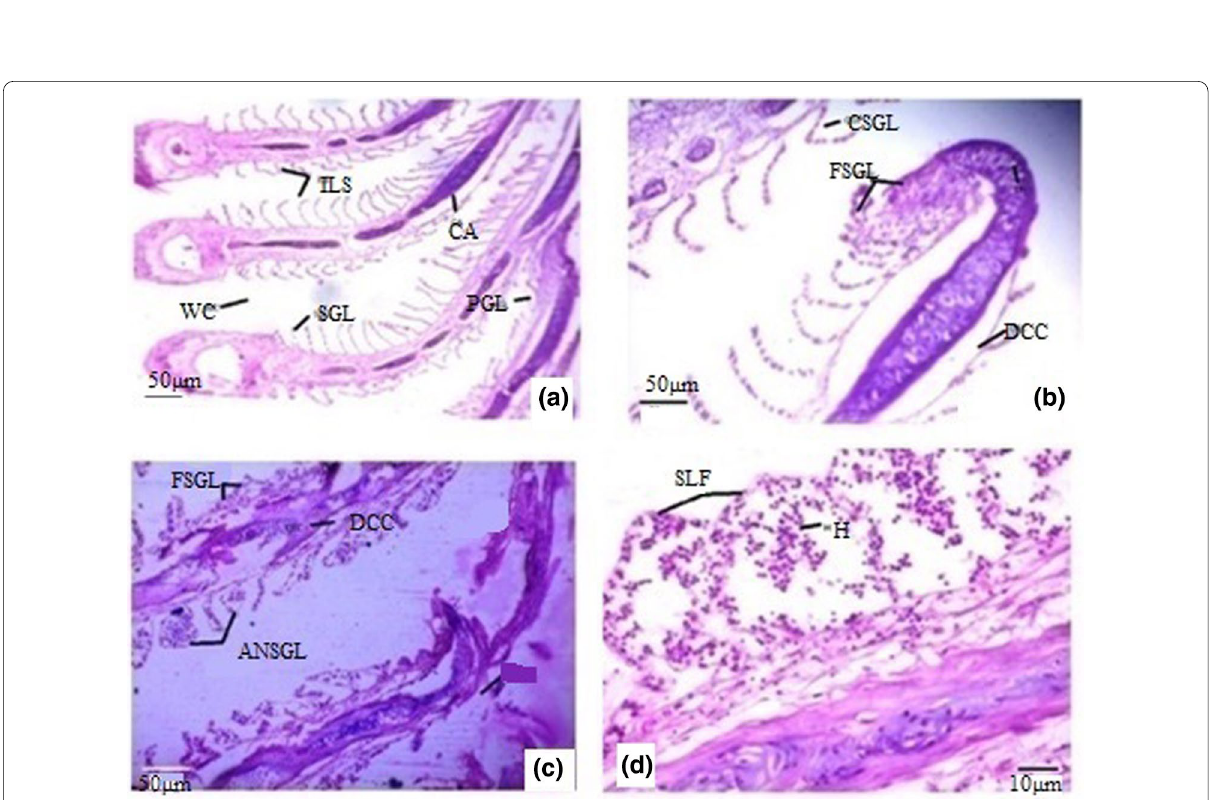
Fig. 4 a Normal gill with inter lamellar spaces (ILS), secondary gill lamella (SGL), water channels (WC). b Infested gill with curling of secondary gill lamella (CSGL), fusion of secondary gill lamella (FSGL), damaged central core (DCC). c Infested gill with fusion of secondary gill lamella (FSGL), damaged central core (DCC) and aneurysm in secondary gill lamella (ANSGL). d Infested gill with hyperplasia